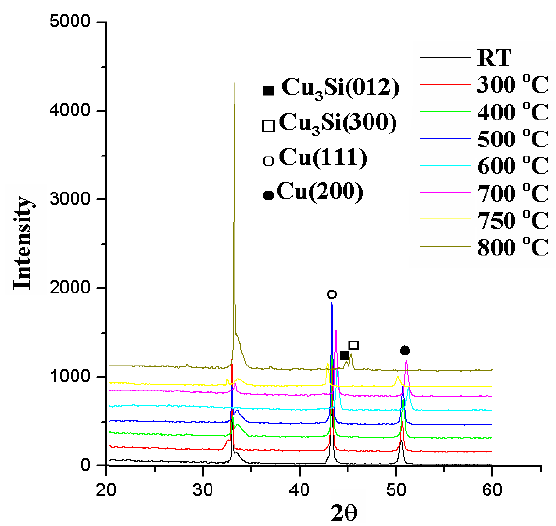
Figure 2. X-ray diffraction patterns for the MgO (3 nm) sample annealed for 5 min at temperatures from room temperature to 800 °C.